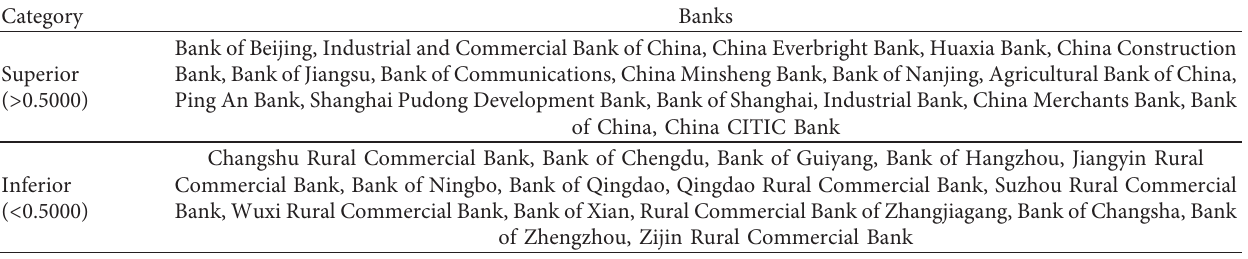
Table 8: Superior and inferior listed banks.